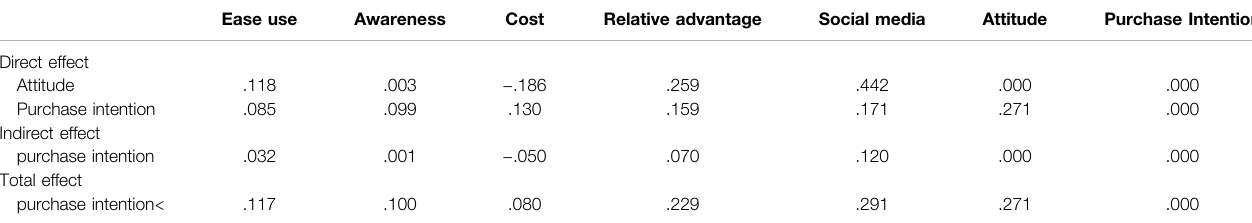
TABLE 5 | Direct, indirect, and total